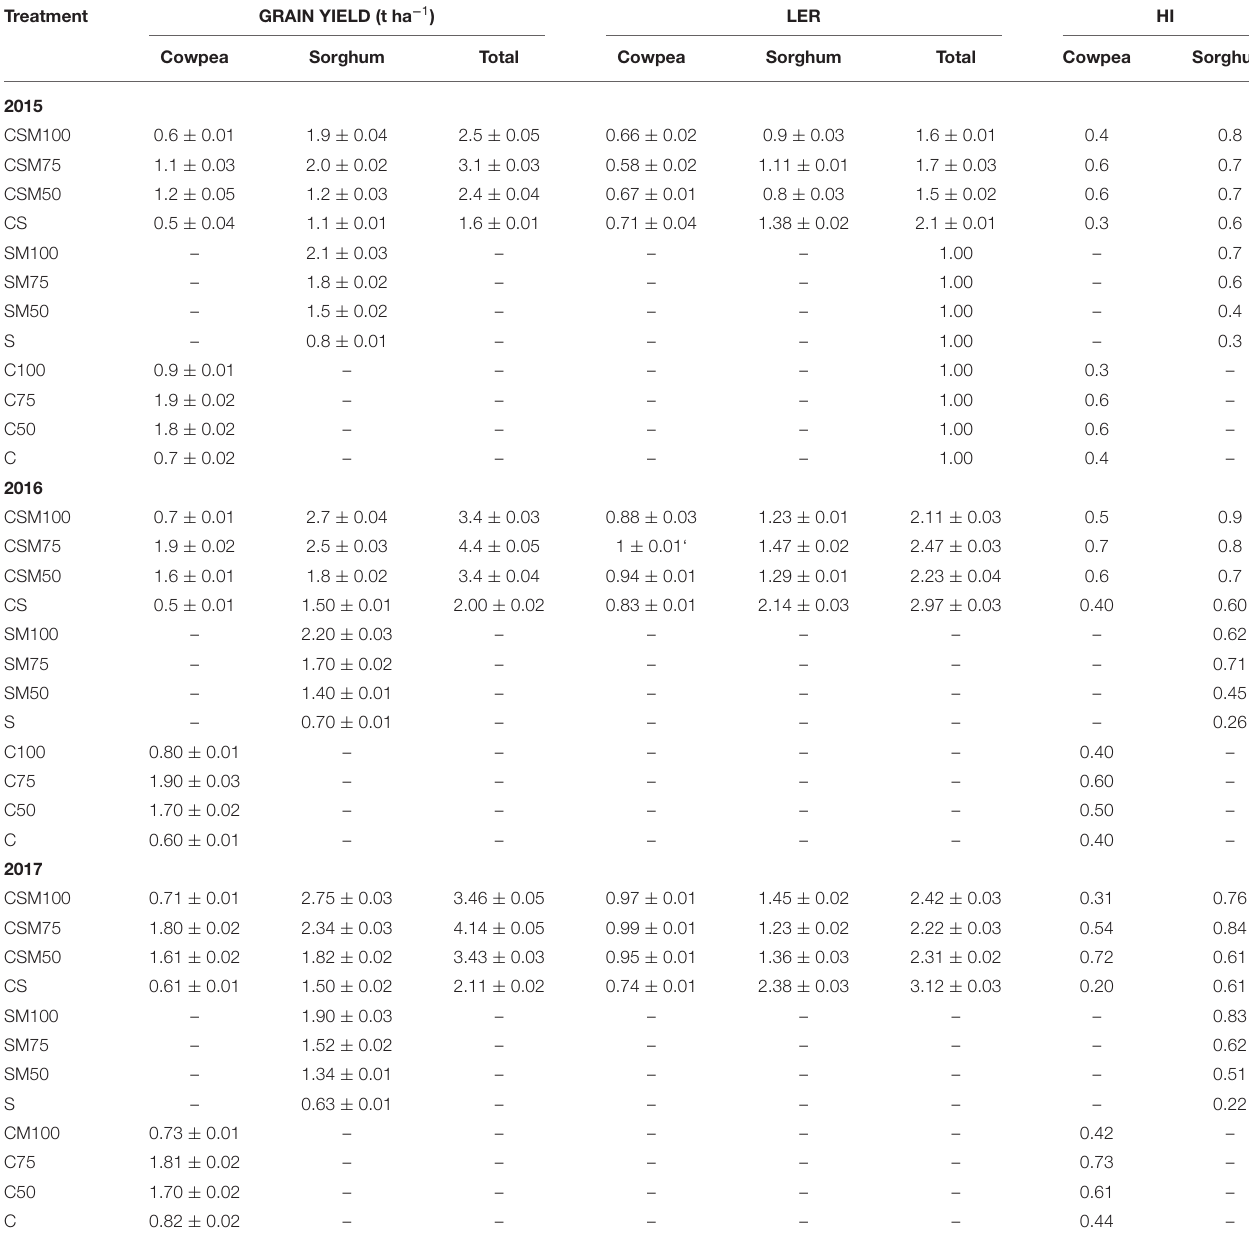
TABLE 5 | Grain yield, land equivalent ratio (LER), and harvest index (HI) of sorghum grown in a pure stand and mixed with cowpeas under the different cattle manure application rates.